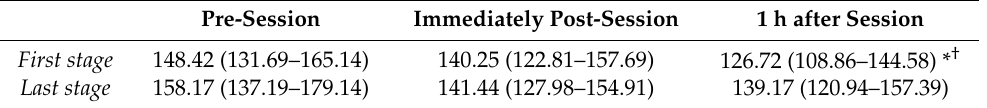
Table 3. Capillary blood glucose (CBG) comparison on the first and last week of exercise visits. Pre-Session Immediately Post-Session 1 h after Session First stage 148.42 (131.69–165.14) Last stage 158.17